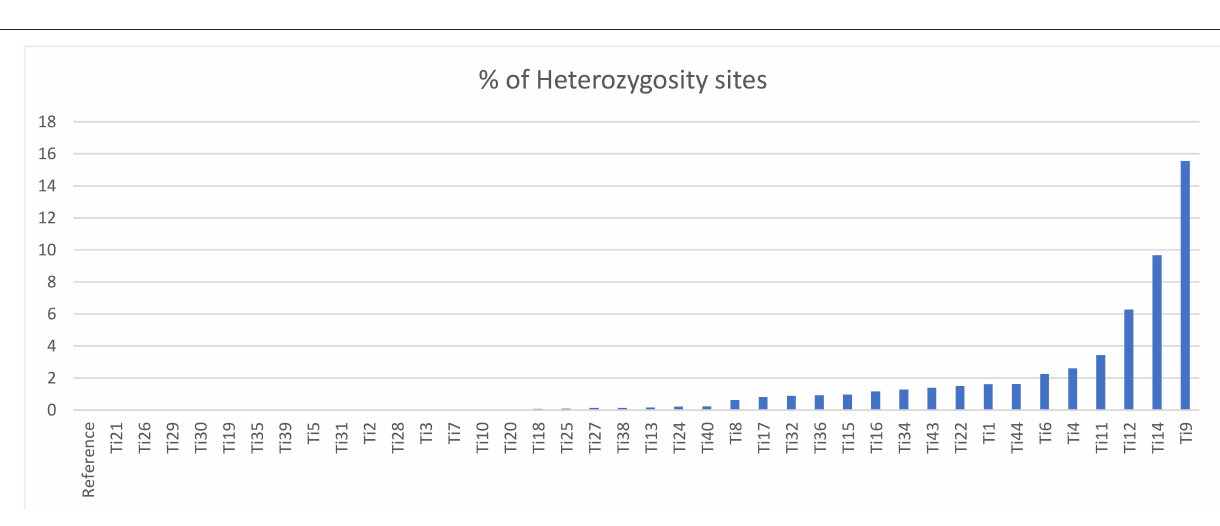
FIGURE 4 | Heterozygosity rates in T. indica